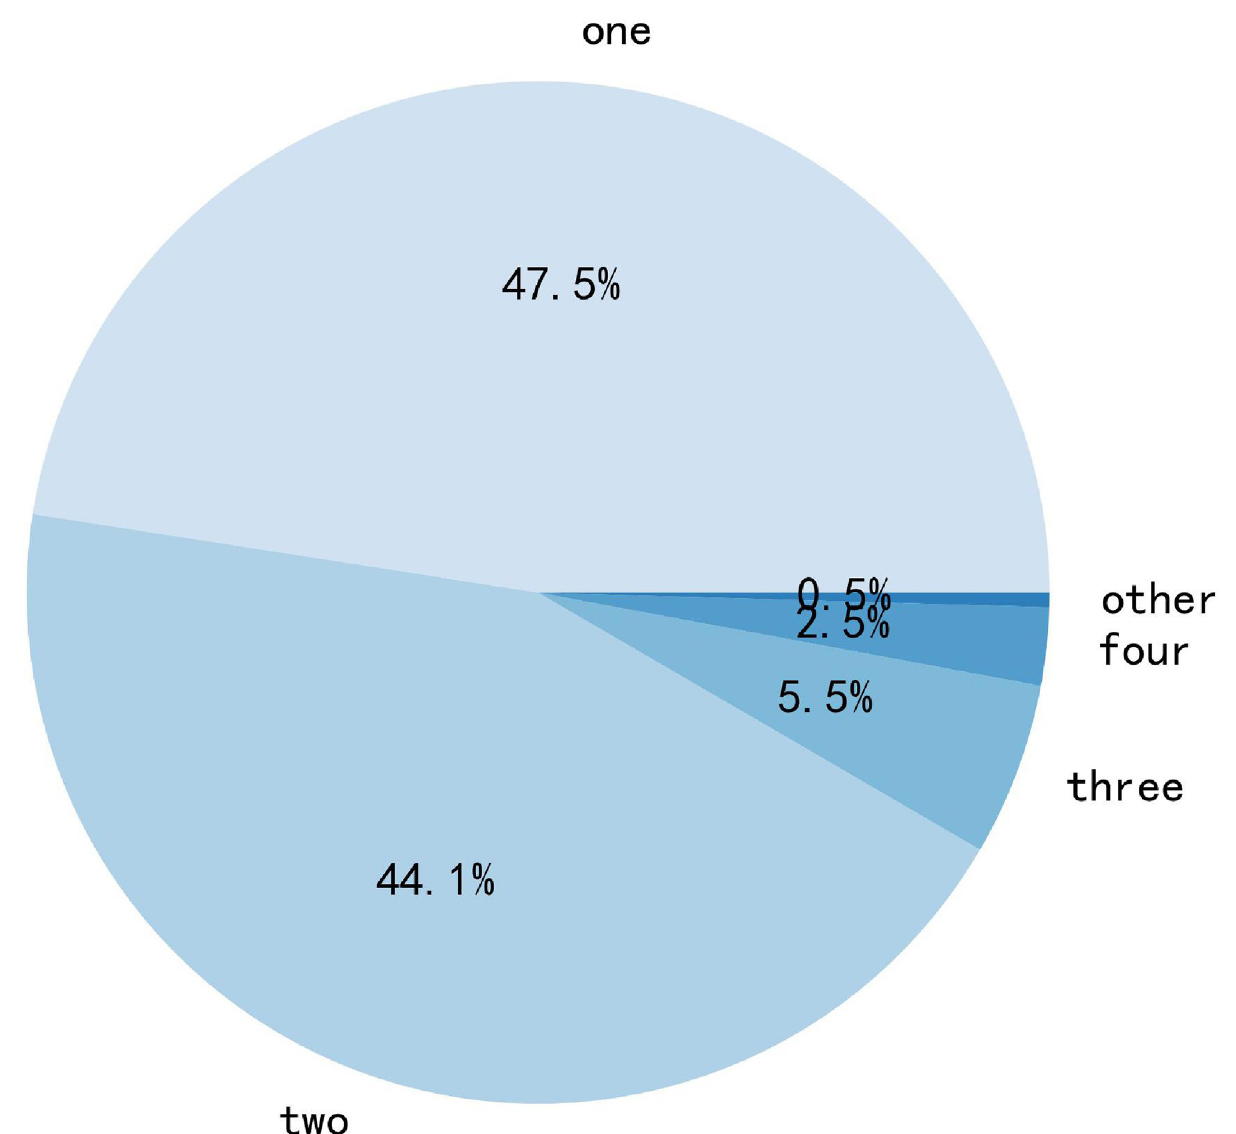
Fig 9. Frequency of words with different